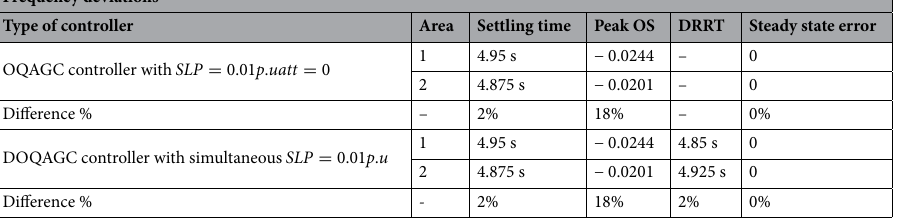
Table 9. Performance of COQAGC in terms of peak overshoot (POS,) settling time and disturbance rejection response time (DRRT).